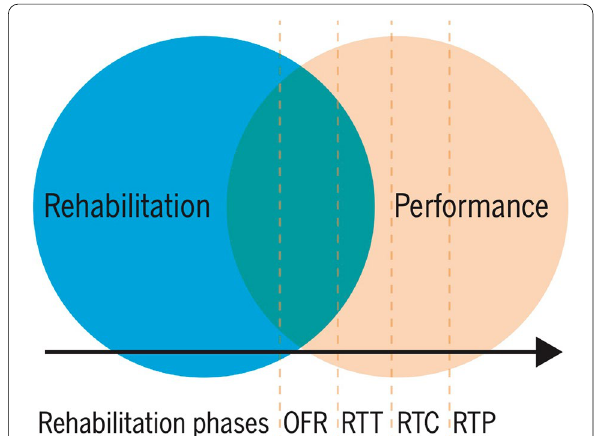
Fig. 1 A return-to-sport process involving a gradual transition from rehabilitation to performance training and a continuum of OFR, RTT, RTC, and RTP. Abbreviations: OFR, on-field rehabilitation; RTC, return to competitive match play; RTP, return to performance; RTT, return to training (with permission